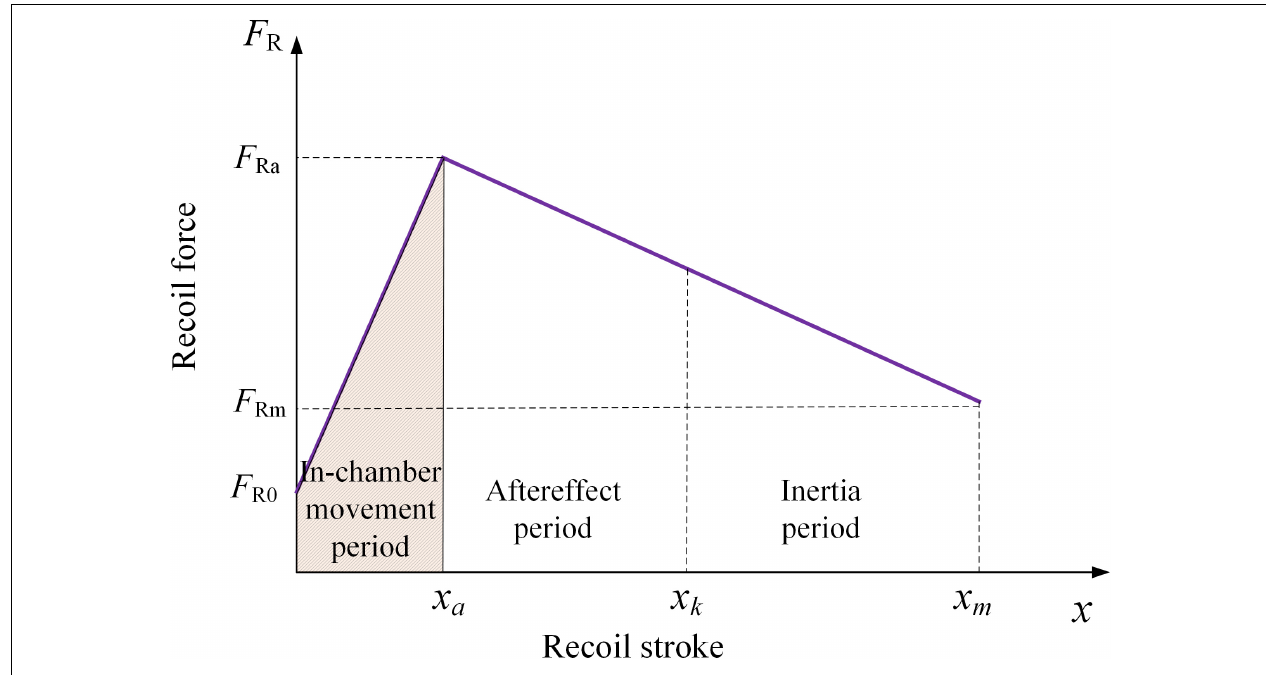
FIGURE 3 | Schematic diagram of ideal recoil force for field artillery.